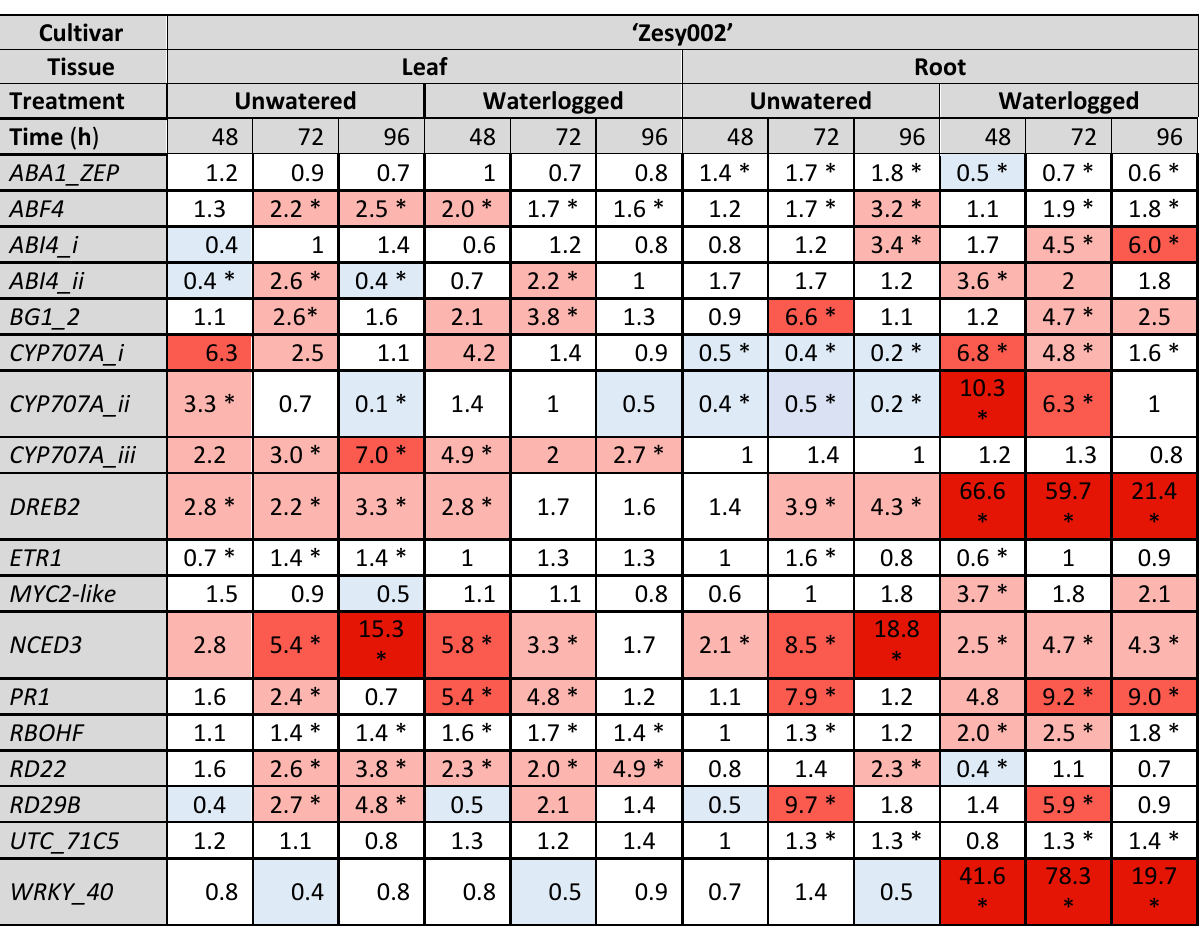
Figure 5. Fold-change in gene expression induced by water stress conditions in leaf and root tissue of Actinidia chinensis var. chinensis ‘Zesy002’ kiwifruit plants after 24 h, 48 h, 72 h and 96 h of water stress treatments in 2021. Plants in the unwatered treatment did not receive any watering from time 0 h, while waterlogged plants were subjected to constant water at quarter pot height. Plants in the control treatment received the standard watering regime of 12 minutes, twice daily. There were five replicate plants/time/treatment. Gene expression was quantified by PlexSet ® NanoString using Actin2 , Glyceraldehyde 3-phosphate dehydrogenase ( GAPDH ), Protein phosphatase 2A ( PP2A ) and ubiquitin-conjugating enzyme ( UBC ) as the reference genes. The genes of interest are shown in the left-most column. Statistical analysis was performed at the log₂ scale, and the heat map shows fold change data between water stressed plants and the control at the same time point. Red shades (as defined in Figure 2) indicate an up-regulation relative to the control, whilst blue represents down-regulation relative to the control. Fold changes of 0.5 – 2 are often considered to be statistically unreliable [25 – 27]. Statistically significant differences from the control at individual time points, as determined by ANOVA at ( p ≤ 0 .05) are identified with an asterisk.